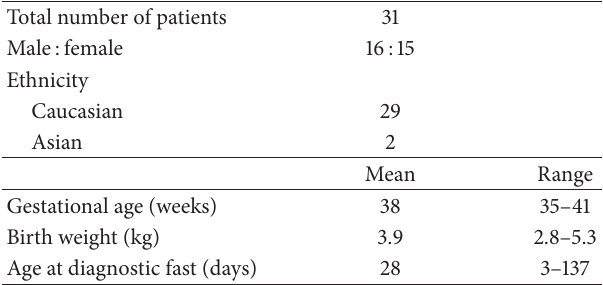
Table 1: Patient